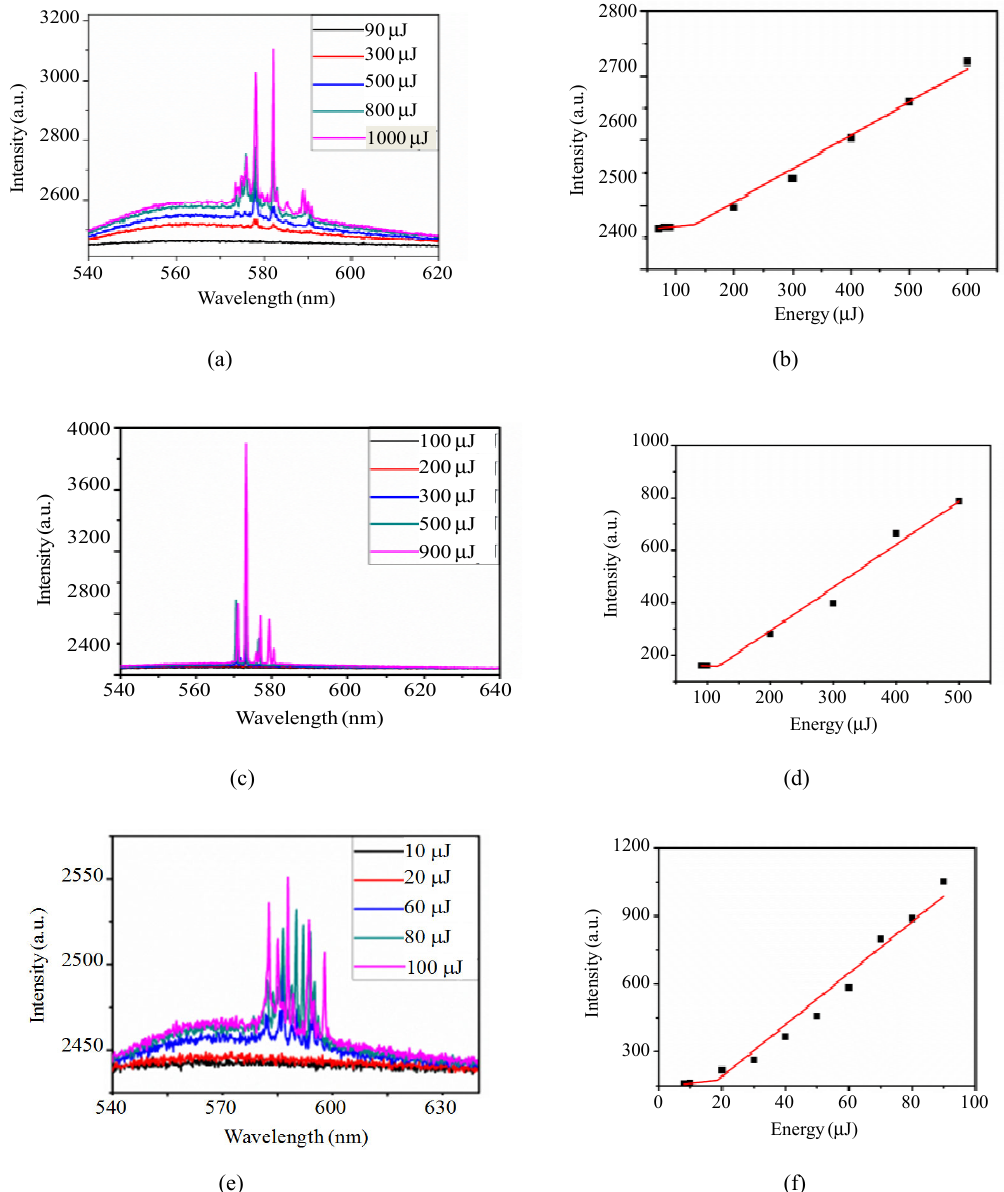
Fig. 5 Random lasing spectra at different pump energies for (a) 0.156 wt.%, (c) 0.208 wt.%, and (e) 0.312 wt.% azo polymers; and input-output relation corresponding to the above (b–f)